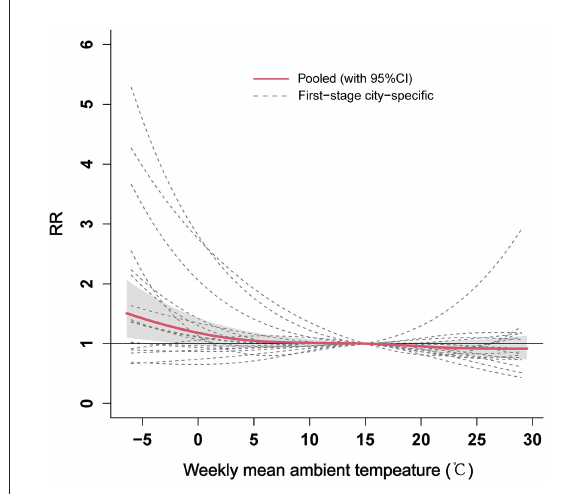
FIGURE4 The overall pooled estimates between weekly mean ambient temperature and ILI for the 17 cities in Shandong Province. ILI, influenza-like-illness; RR, relative